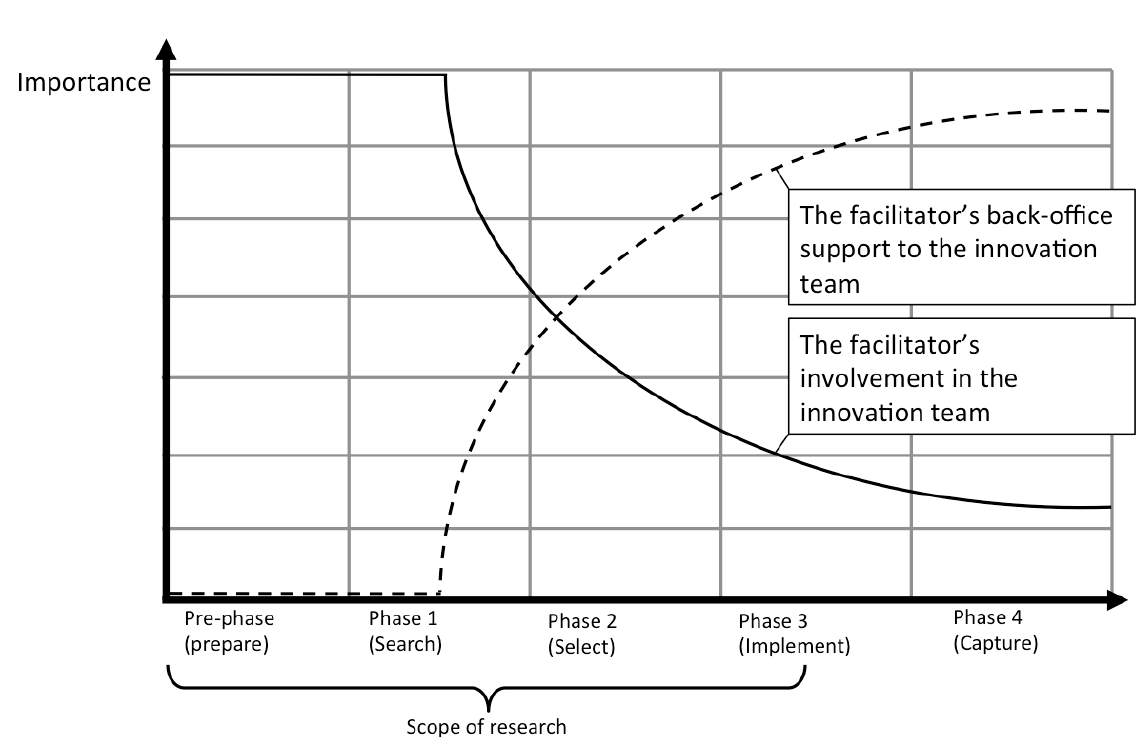
Fig. 6 . The figure demonstrates how the facilitator’s activities, involvement, and presence in innovation teams change during an ongoing innovation